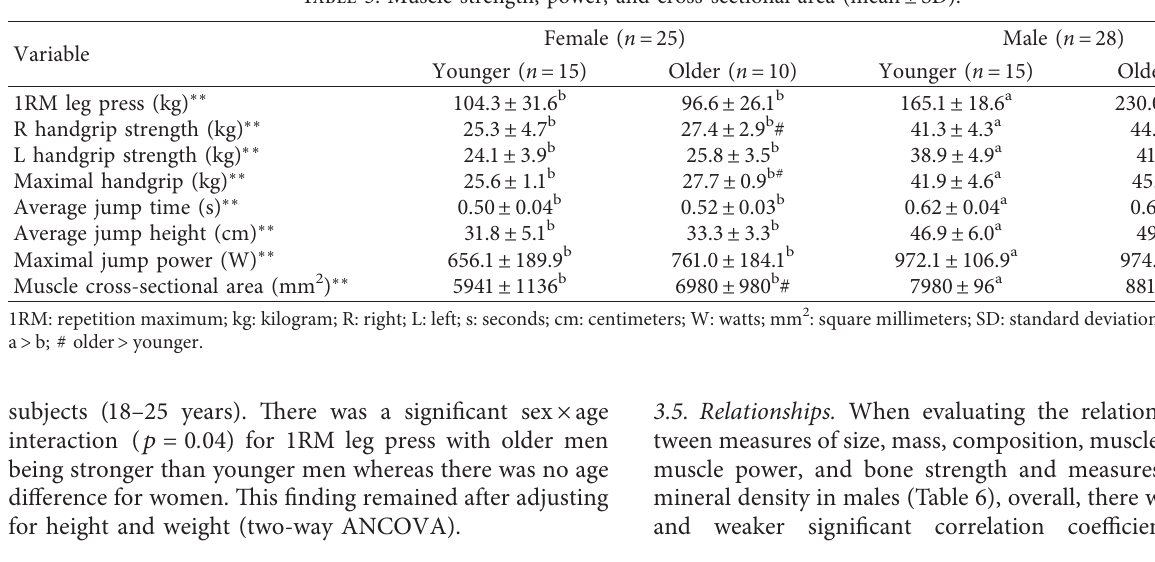
Table 5: Muscle strength, power, and cross-sectional area (mean ±